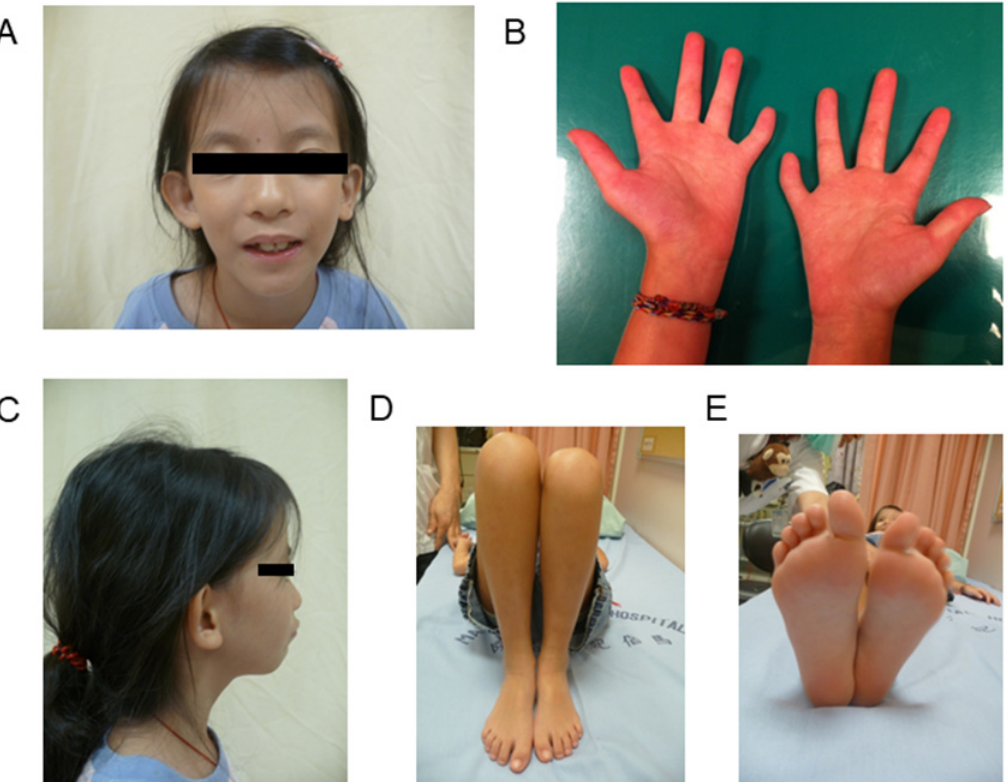
Figure 1. Clinical features of a 5-year-old girl with Silver–Russell syndrome (SRS). She had IC1 hypomethylation and an SRS score of 12. ( A ) Triangular shaped face. ( B ) Clinodactyly of bilateral fifth fingers and right hand larger than the left hand. ( C ) Small chin. ( D ) Right leg longer than the left leg. ( E ) Right foot larger than the left foot. IC, imprinting center.